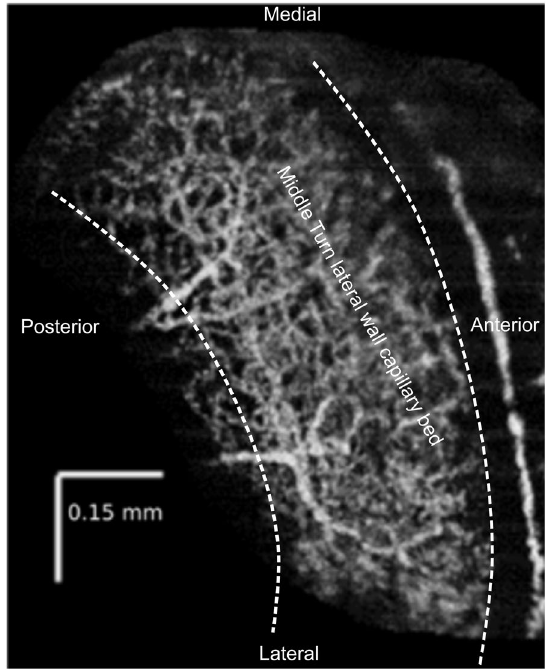
Figure 1. En face reconstruction of the ventral view of lateral wall blood flow in the middle turn of a murine left cochlea using OCTA. The middle turn organ of Corti (not visible) runs mediolaterally from low to high frequency along the cochlear spiral, between the two dashed lines, and includes the approximate location of a typical region of interest selection for flow analysis. This image is an average of 5 consecutive scans in the absence of